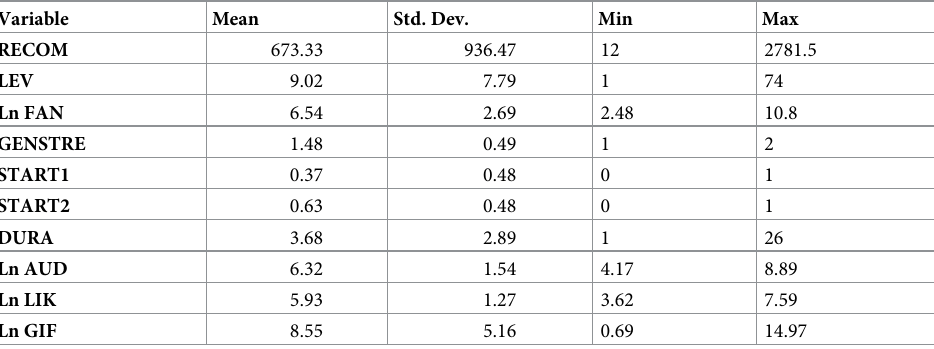
Table 3. Descriptive statistics of the logarithmic variables (N = 1090).